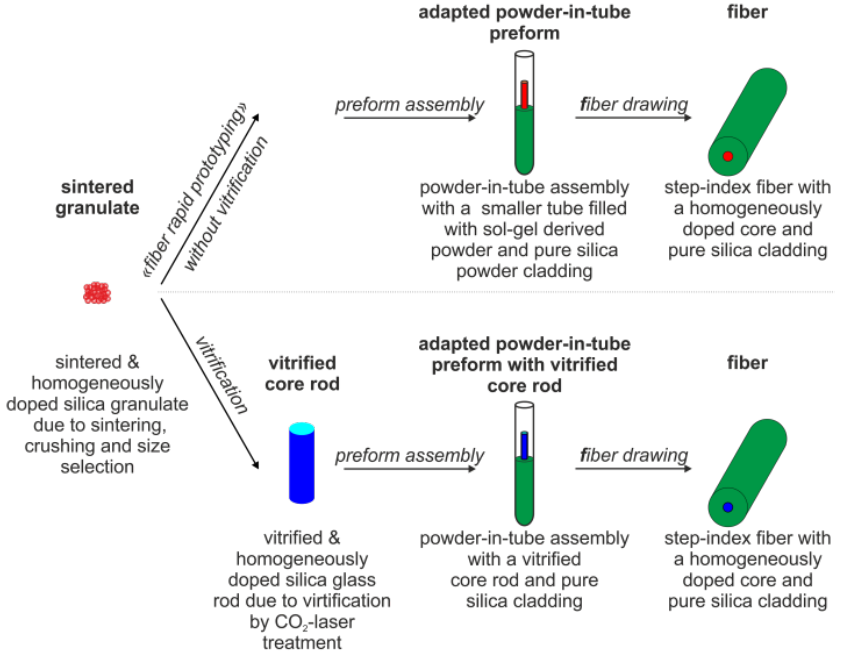
Figure 3. Overview of our preform assembly, fiber drawing and additional vitrification [7].